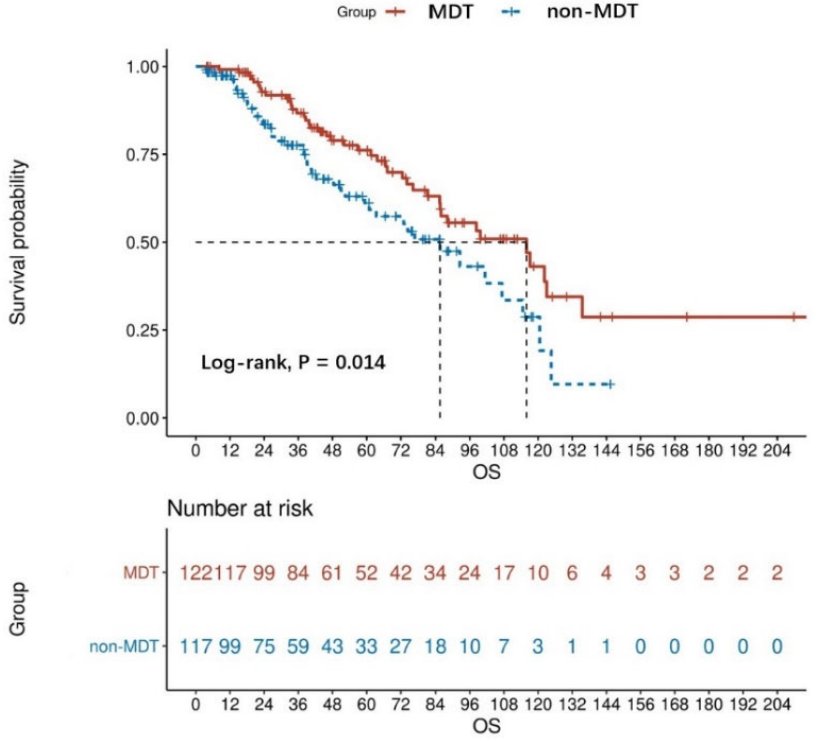
Figure 2. OS curves of MDT ( n = 122) and non-MDT ( n = 117) patients with advanced GISTs; the result was obtained from the univariate analysis.